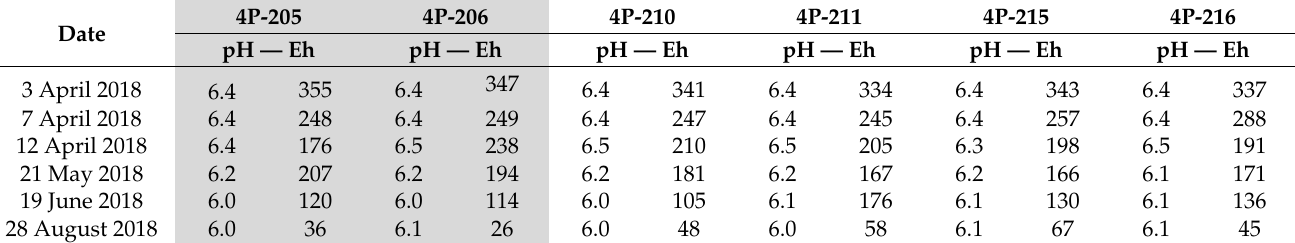
Table 1. pH and Eh (mV, adjusted from measured ORP in mV relative to Ag/AgCl) in the six production wells measured at various times during the test. Shaded columns indicate well patterns receiving